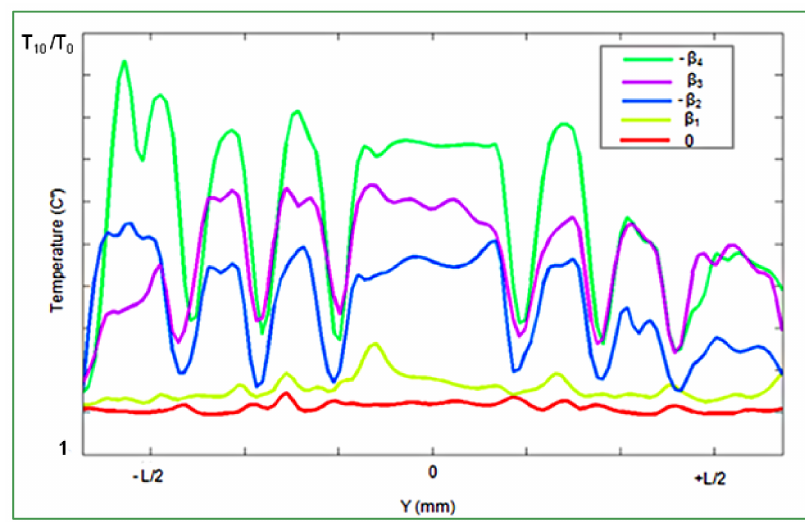
Figure 6. The variation of skidding angles for constant loading l 3 = 260 kN at velocity lower than 120 km/h.